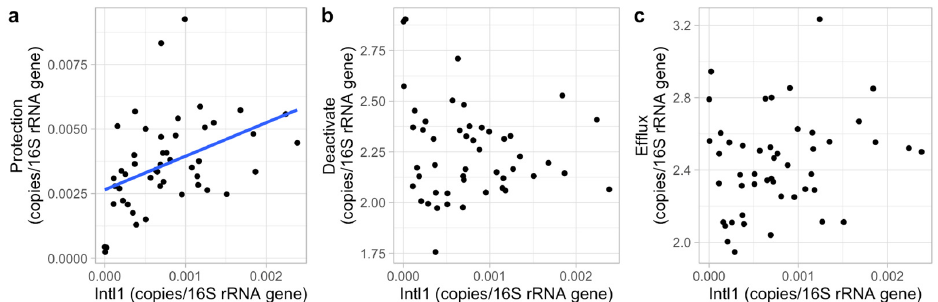
Figure 6. The relative concentration of the intl1 gene (copies/16S rRNA gene) for each ARG mecha- nism (a, deactivate; b, protection; c, efflux). The ARG concentration was log 10 (x*10 6 ) transformed except for protection to meet normal distributions. Significant relations are shown by the blue line indicating the linear regression line.